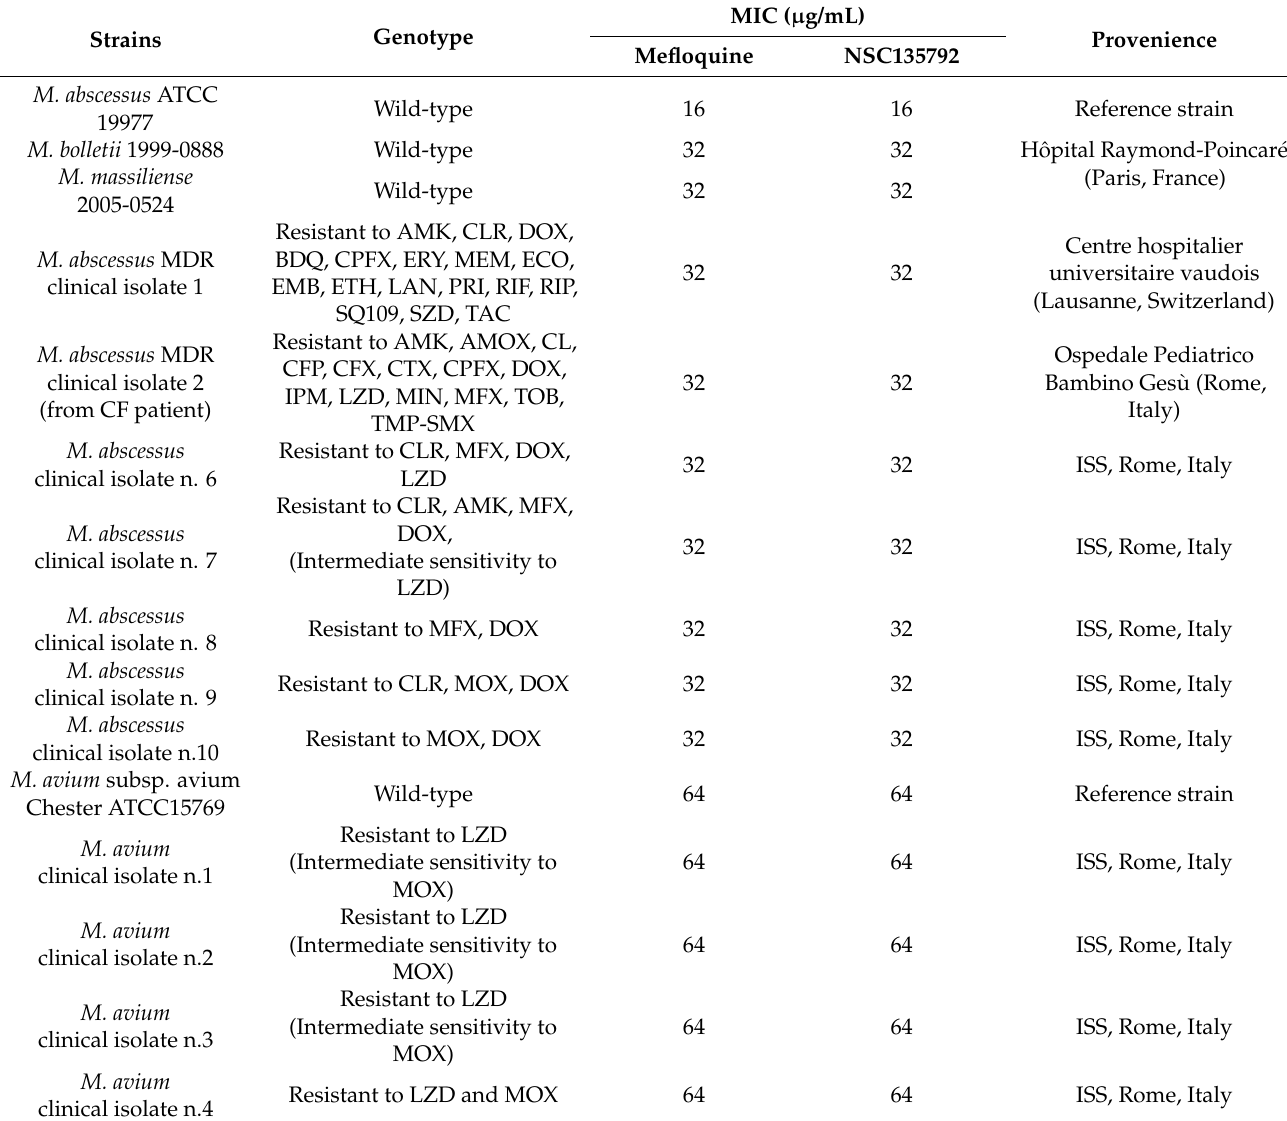
Table 2. Antimycobacterial activity of mefloquine and NSC135792 against NTM reference strains and drug-resistant clinical